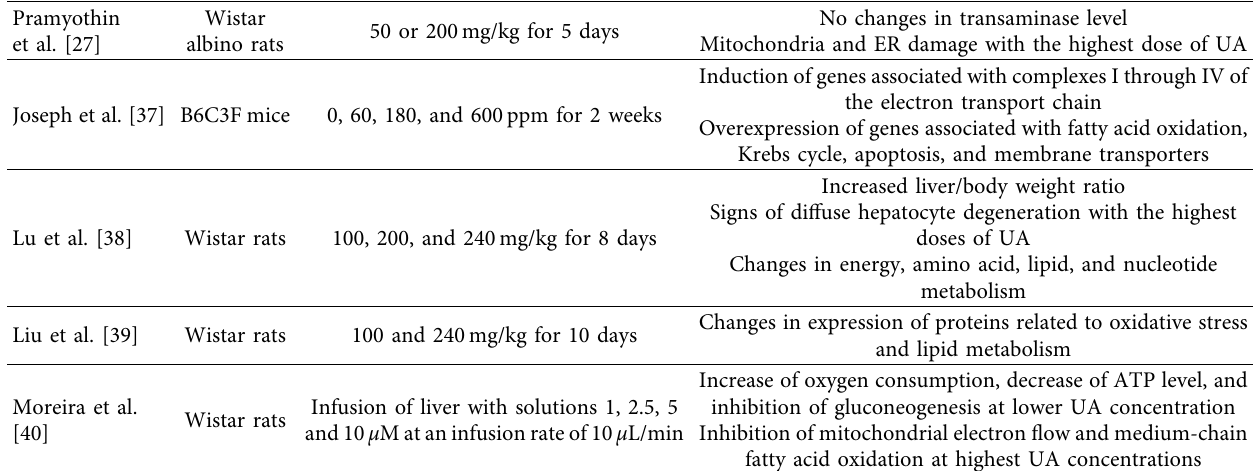
Table 2: Main outcomes of the in vivo studies on UA